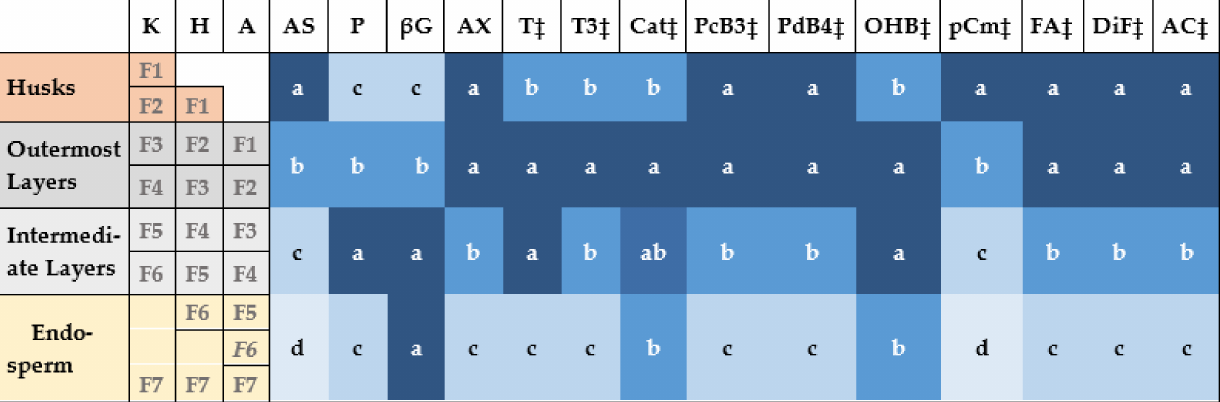
Figure 7. Tukey’s HSD groupings for a number of compounds for the different sections of the grains across three food barley genotypes. The colored left columns represent the different pearling fractions (F1–F7) of the Kamalamai (K), Hindukusch (H) and Annapurna (A) used for the aggregation into four grain sections shown in the first column. A: Ash; P: protein; β G: β -glucans; AX: arabinoxylans; T: tocopherols; T3: tocotrienols; Cat: catechins; PB3: Procyanidin B3; PB4: prodelphinidin B4; OHB: m- or o-hydroxybenzoic acid; pCm: bound p-coumaric acid, FA: bound ferulic acid; DiF: bound diferulic acid; AC: total antioxidant capacity. ‡ Analyses carried out on log-transformed